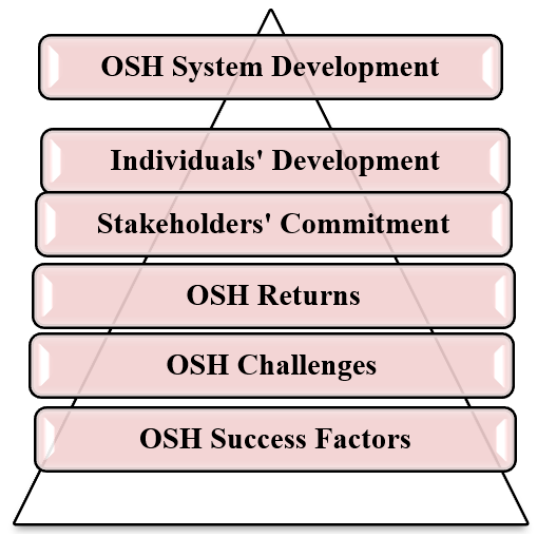
Figure 3. The central themes developed based on the conducted interviews.